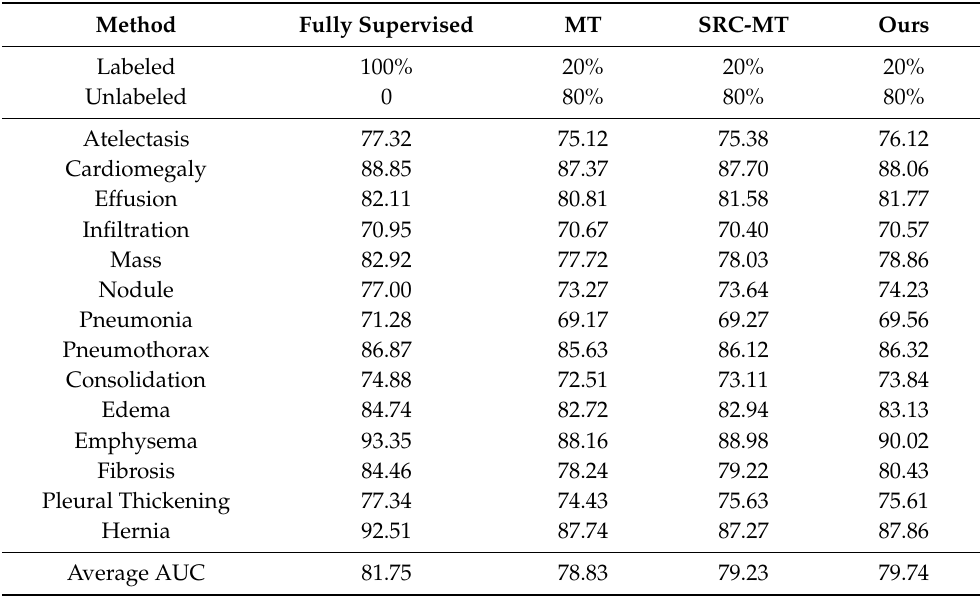
Table 4. Semi-supervised model’s AUC performance with respect to different categories in the ChestXray-14